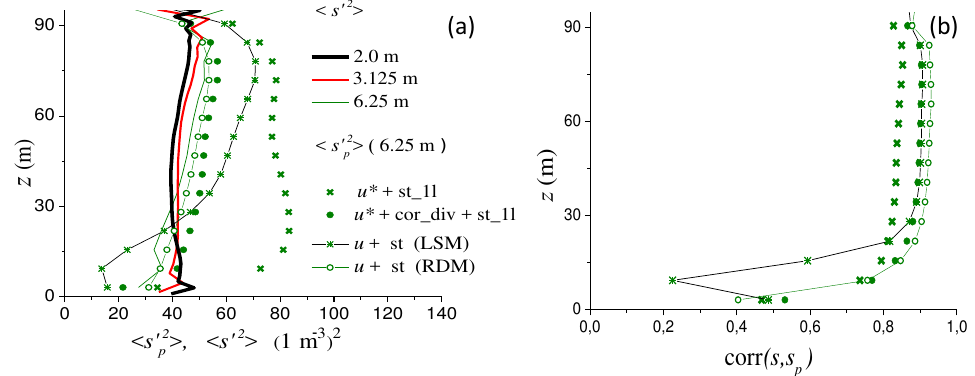
D E s P (cid:48) 2 of concentration s P , deter-